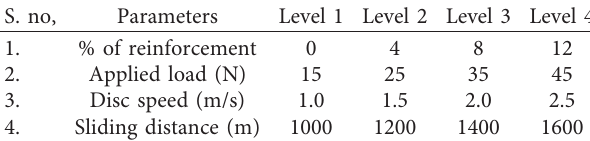
Table 1: Chemical opus of aluminum alloy (AA7079).